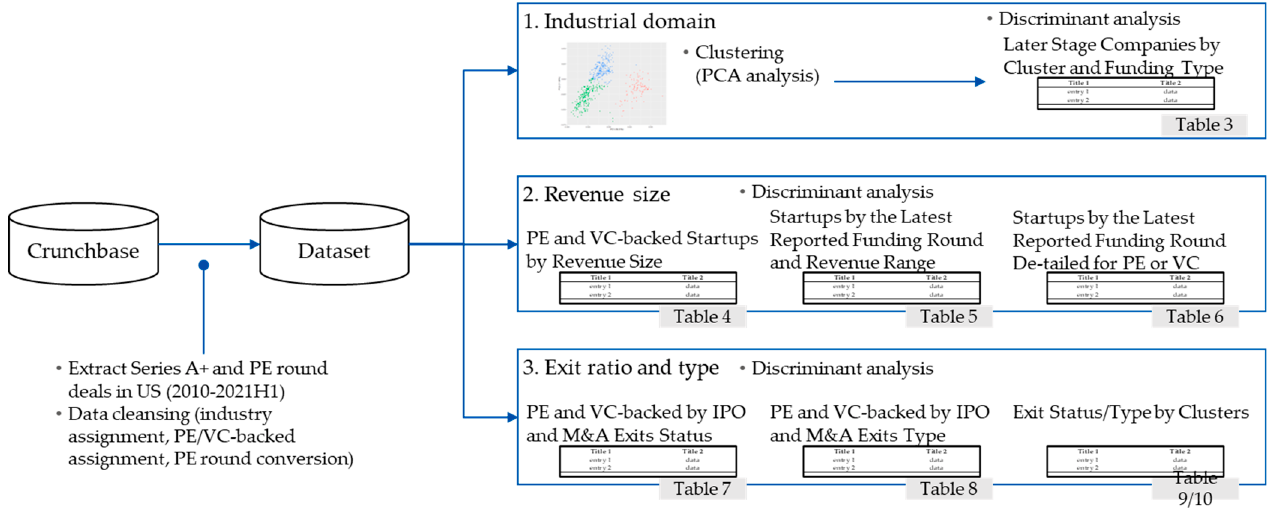
Figure 1. Overview of the methodological approach. Publicly declared M&A data was sourced from the database. Then, different patterns between PE and VC-backed startups were studied regarding the industrial domain, revenue size, exit ratio, and